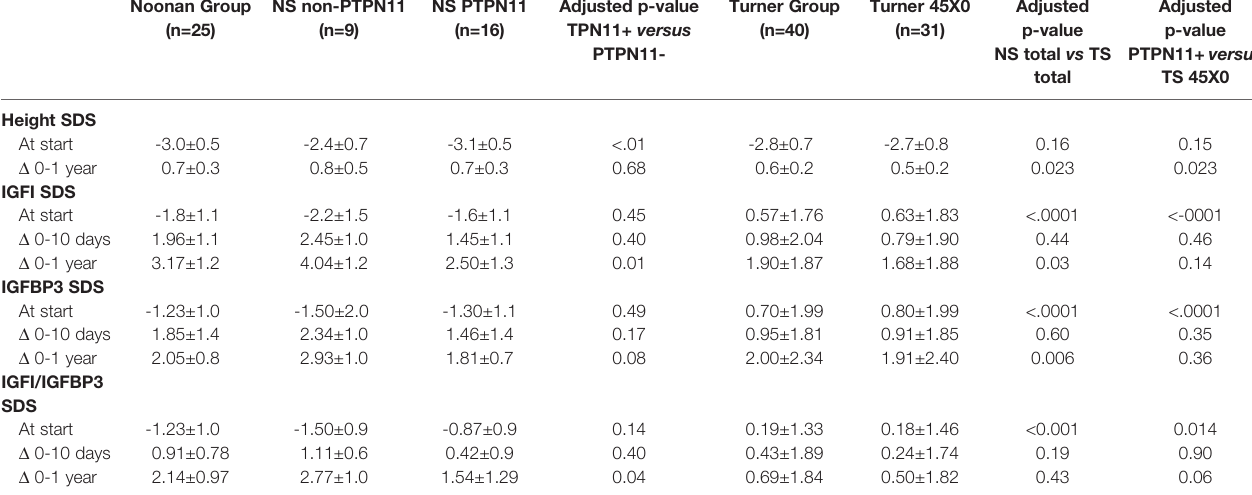
TABLE 2 | Comparison of changes in height, IGF1, IGFBP3, and IGF1/IGFBP3 ratio between Noonan (NS) and Turner groups (TS) on rhGH treatment.